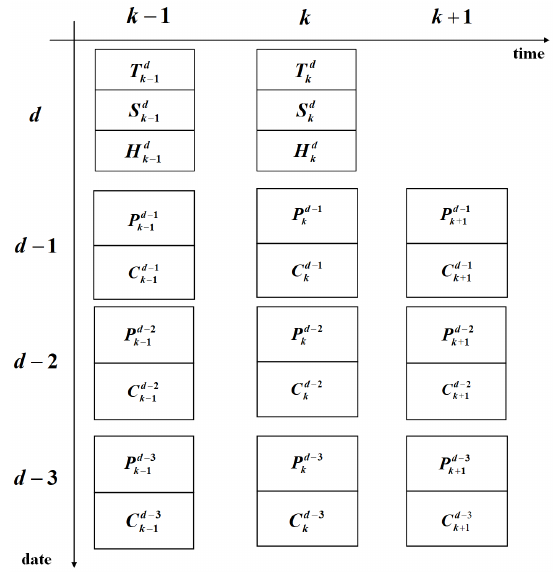
Figure 7. Features of the input .